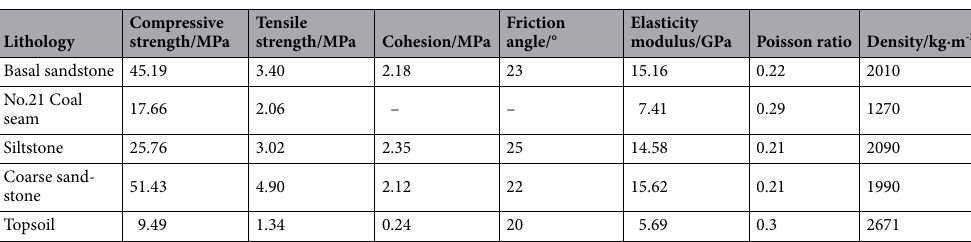
Table 1. Mechanical properties of rock and soil